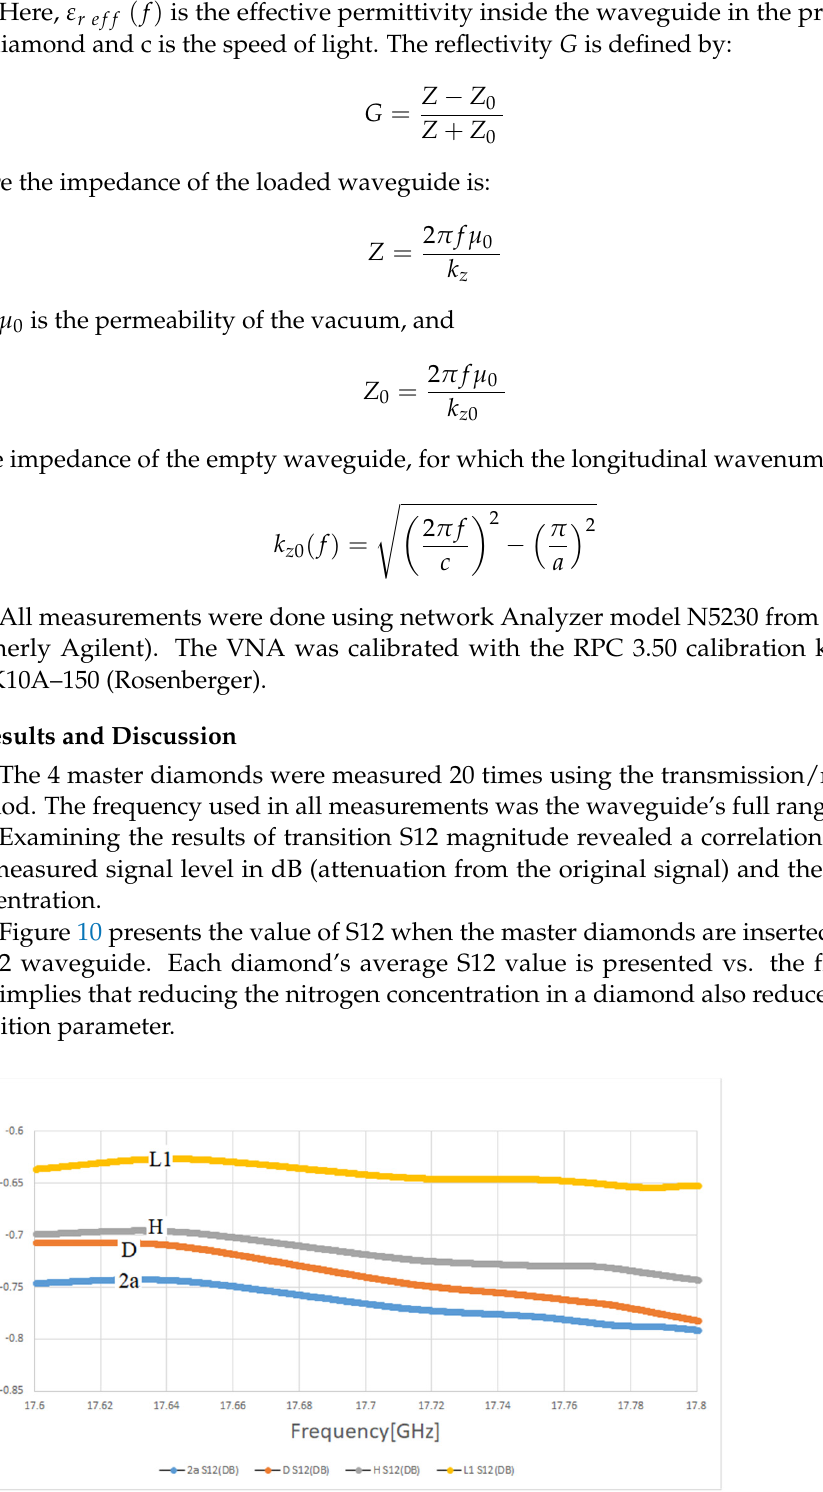
Figure 10. S12 magnitude of master diamonds in a frequency range between 17.6 and 17.8 GHz. The signal level (S12) measured is correlated with the nitrogen levels.